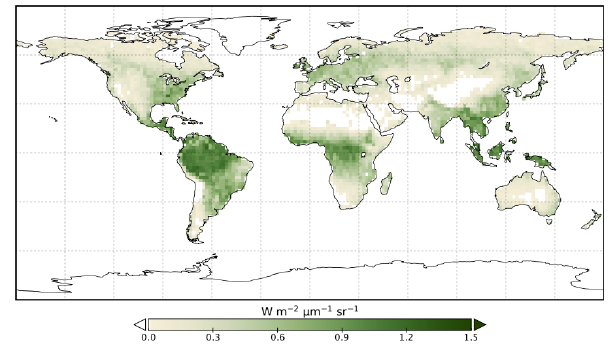
Figure 3. Annual mean residual between model SIF post and ob- served SIF for